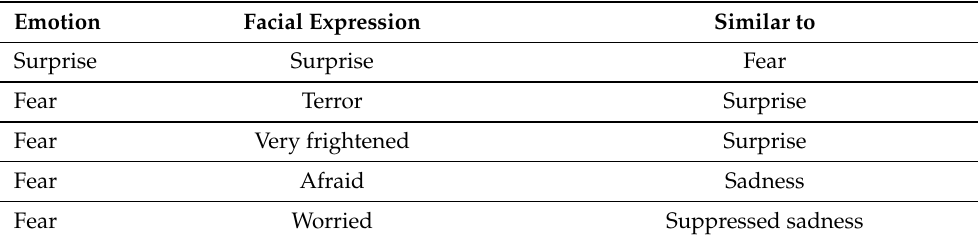
Table 5. Similar facial expressions associated with the emotions of surprise and fear, according to their facial features (more detailed information can be found in Faigin